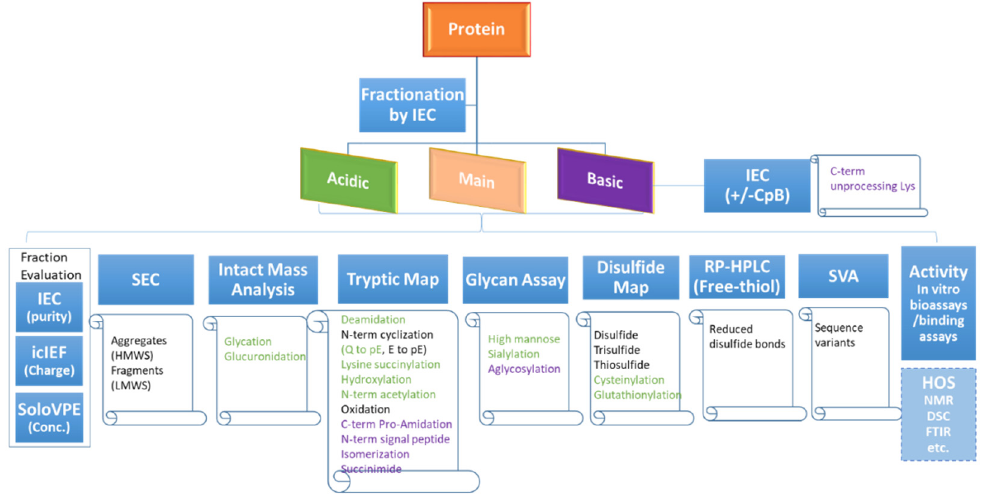
Figure 7. A flowchart diagram showing the charge variant characterization workflow with recom- mended assays to monitor various product attributes.